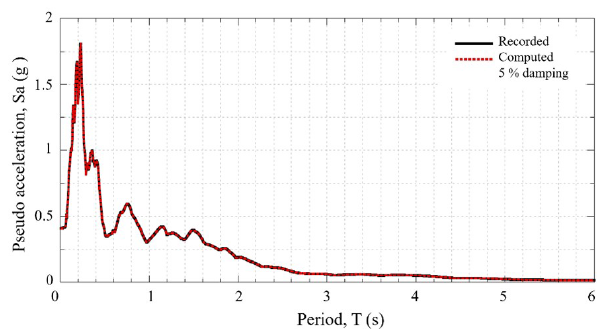
Figure 11. Comparison between the recorded and calculated spec- trum after the propagation of the deconvolved earthquake.